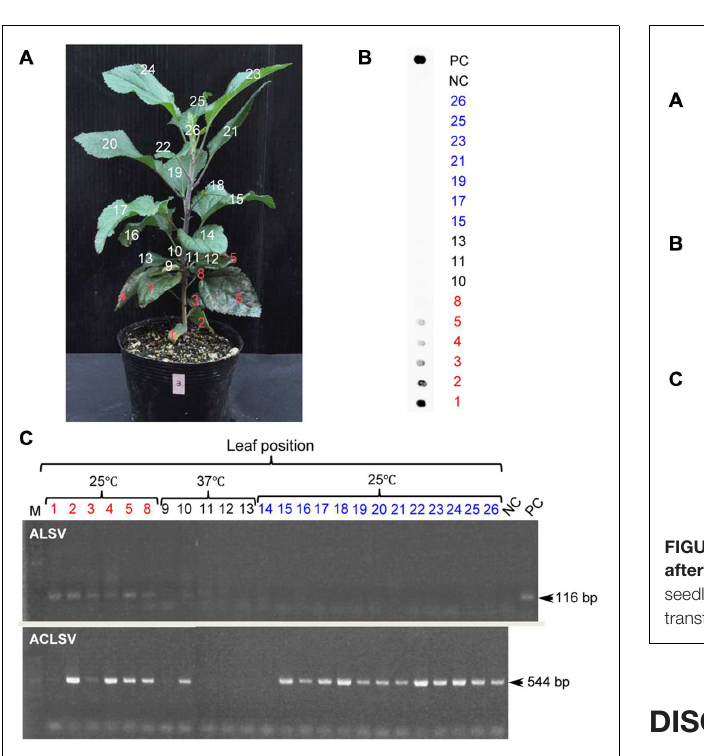
FIGURE 4 | RT-PCR detection of ALSV and ACLSV from an apple seedling after high-temperature treatment. (A) Apple seedling grown at 37 ◦ C for 4 weeks followed by 25 ◦ C for 2 months. (B) Dot-blot hybridization of numbered leaves from the apple seedling in (A) . (C) RT-PCR detection of ALSV and ACLSV from numbered leaves from the apple seedling in (A) .